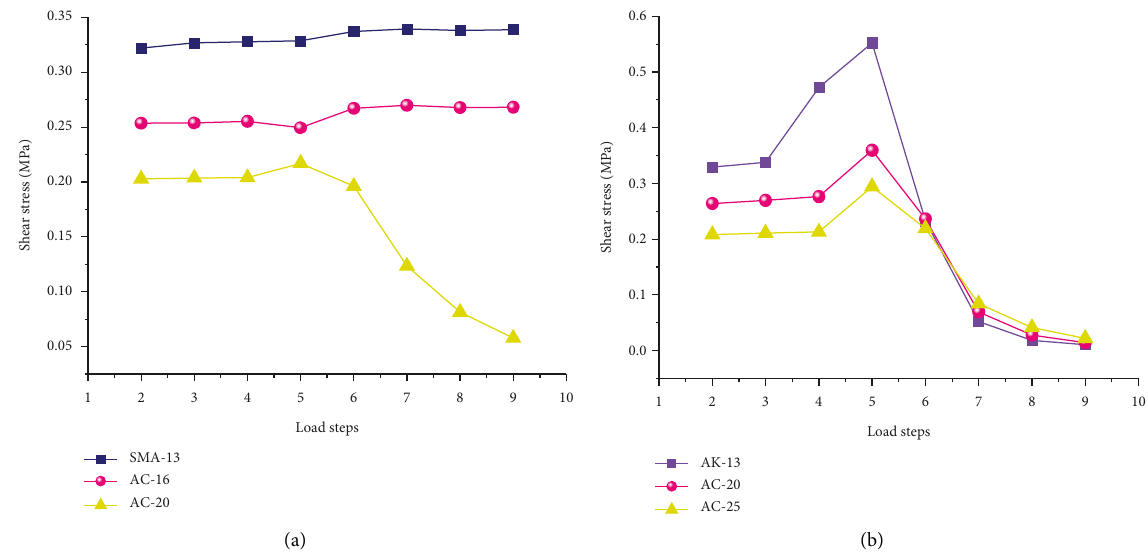
Figure 14: Shear stress response of the asphalt pavement outside the tunnel. (a) Maximum shear stress outside tunnel in Str-1. (b) Maximum shear stress outside tunnel in